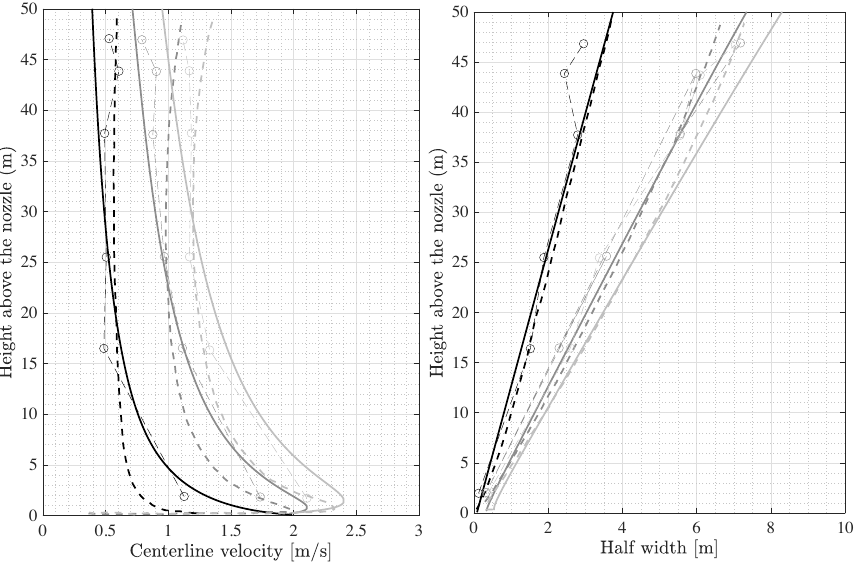
Figure 5. Comparison between centerline velocities and half width of the bubbly layer from the model, numerical results from Bohne et al. [27] and measured values from experiments [38]: ( left ) centerline velocities and ( right ) half width of the bubbly layer. The solid lines represent the computed results from the model, the dashed lines indicate the numerical results from the literature and the circles show the values measured experimentally. Three air flow rates involving 0.024 (black lines), 0.283 (dark grey lines), and 0.59 (light gray lines) m 3